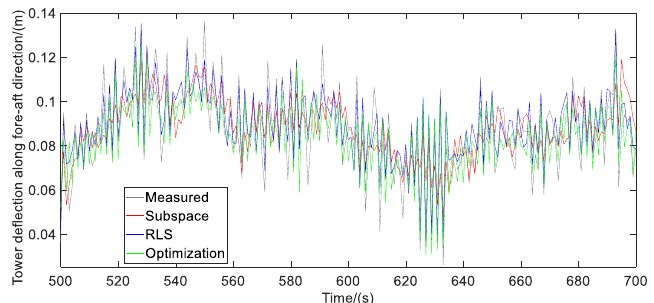
Figure 14. Comparison of tower deflection under scenario Type 3.